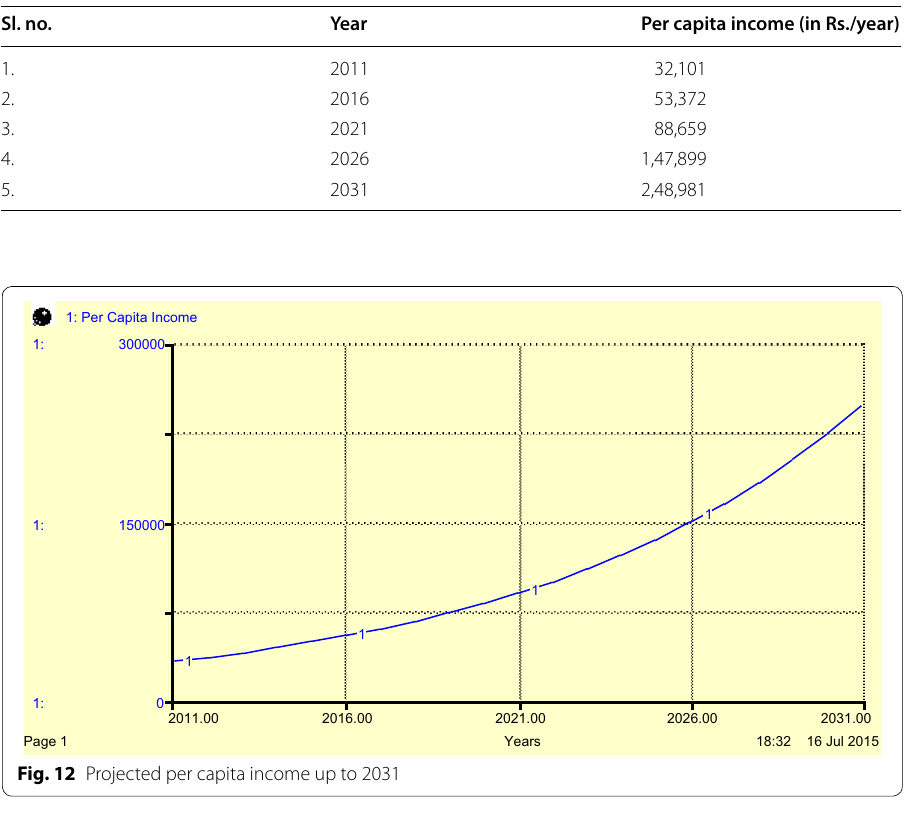
Table 11 Projected production of cereals, pulses, fruits, vegetables, and flowers Sl. no. Year Yield of cereals Yield of pulses Yield of fruits Yield of vegeta- Yield of flowers (in 000’ kg/km 2 ) (in 000’ kg/km 2 ) (in 000’ kg/km 2 ) bles (in 000’ kg/ (in 000’ kg/km 2 km 2 )